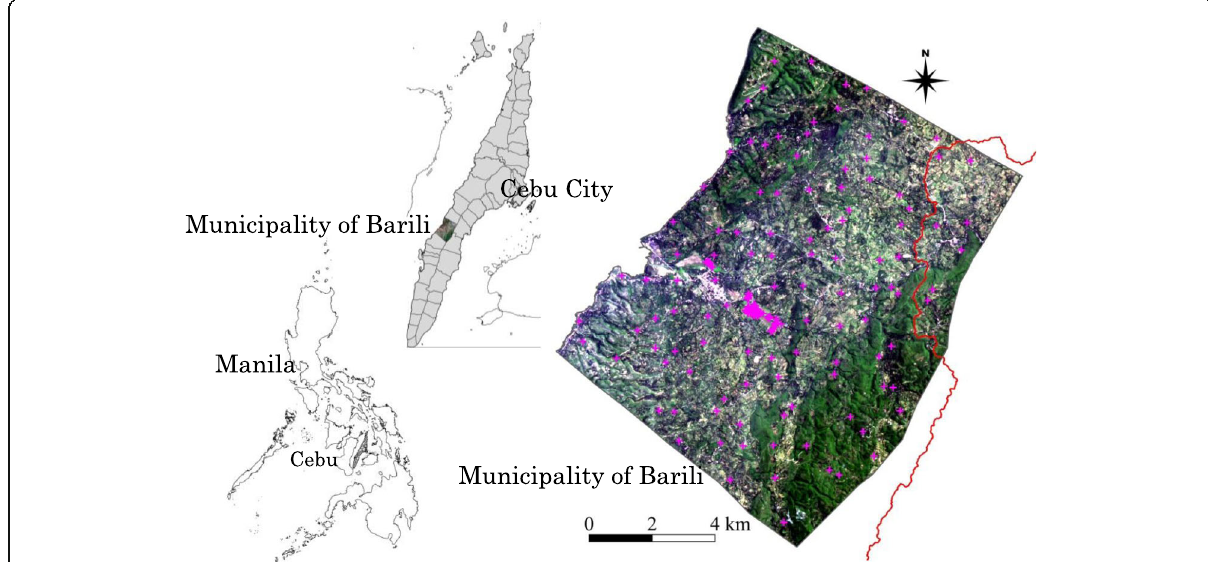
Fig. 1 The location of the Municipality of Barili (natural color composite) as the study area in the Province of Cebu. The distribution of samples (magenta), and the mountain ridgeline